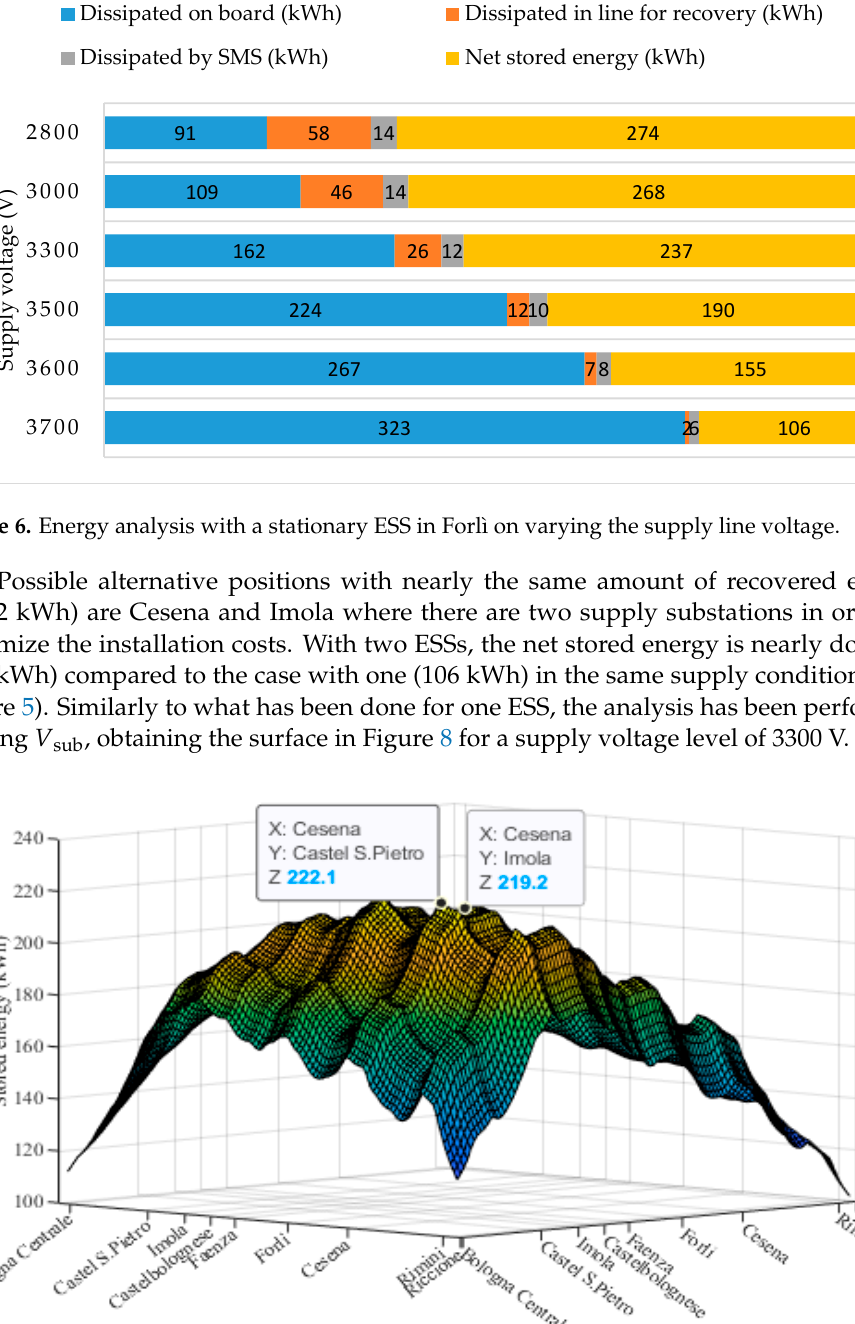
Figure 7. Recovered energy on varying the location of the two ESSs with the actual supply voltage level.